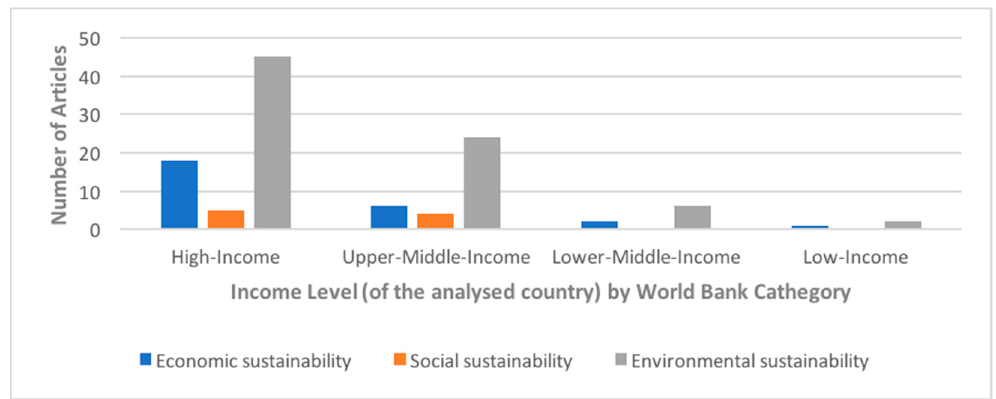
Figure 8. Dimensions of sustainability focused on in articles by development level of countries.